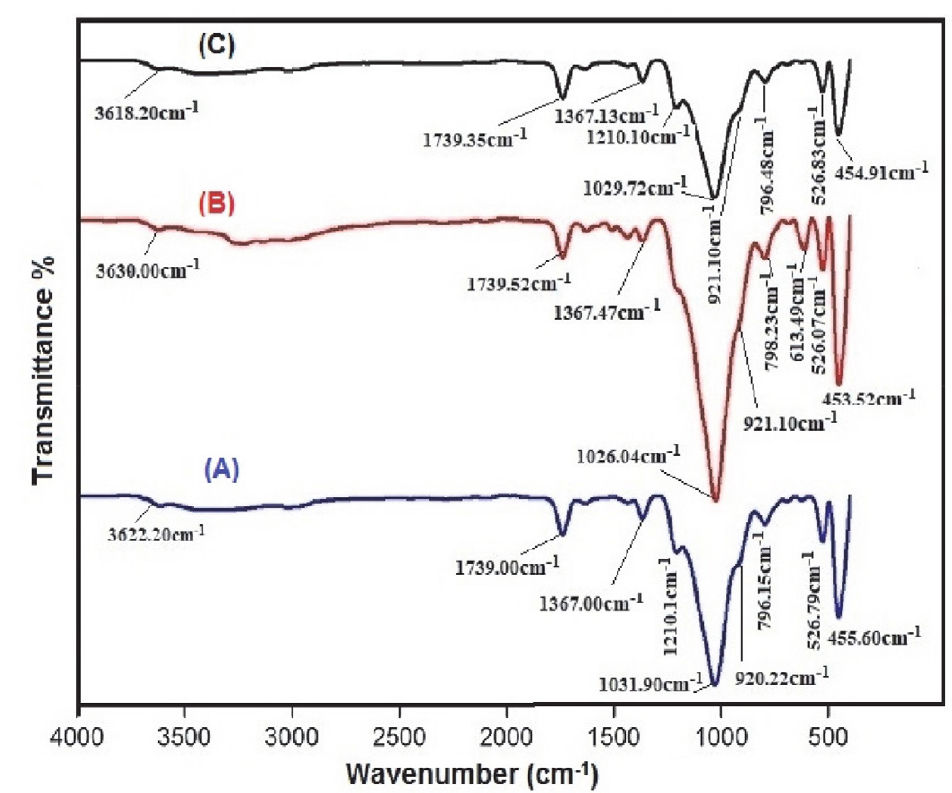
Figure 5: FTIR spectra of (A) MMT K10, (B) loading of CuO nanoparticles, (C) removal of hexavalent